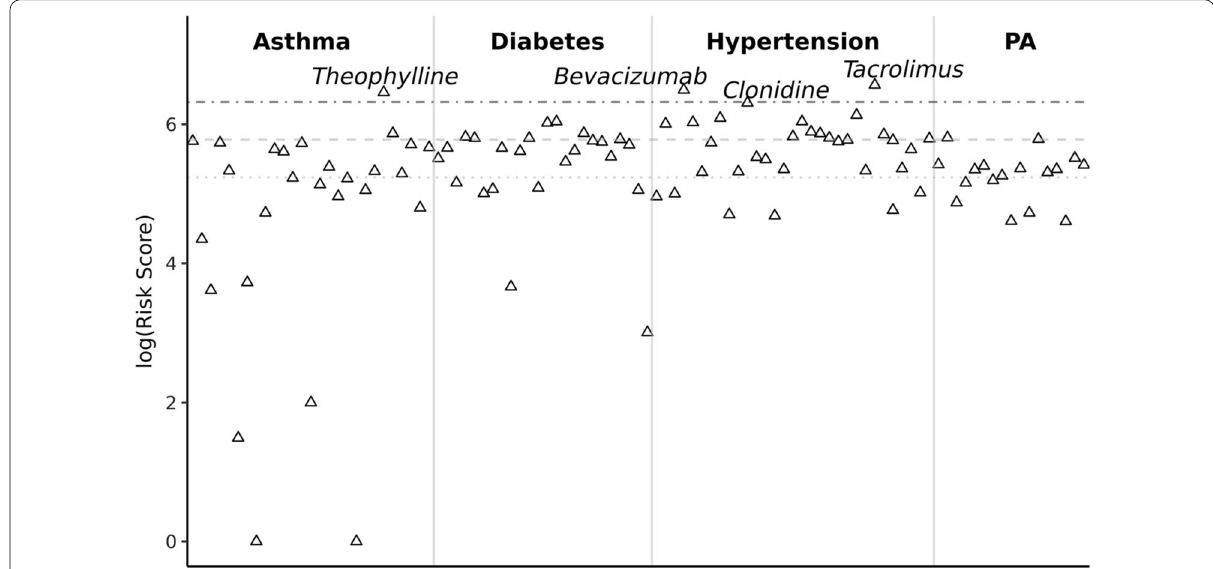
Fig. 2 Aircrew-centric adverse effect risk scores for FDA-approved medications for asthma, diabetes, and hypertension. Control lines were established using medications approved for use in flight operations as indicated by Prudhomme [5] (“PA” section). Medications above and within 10% of the upper control line (UCL) are indicated by name, all other medications and adverse effect scores are available in supplementary information. PA medications reported as approved for use in Prudhomme’s study; UAL = PA medications reported as approved for use in Prudhomme’s study; UAL =